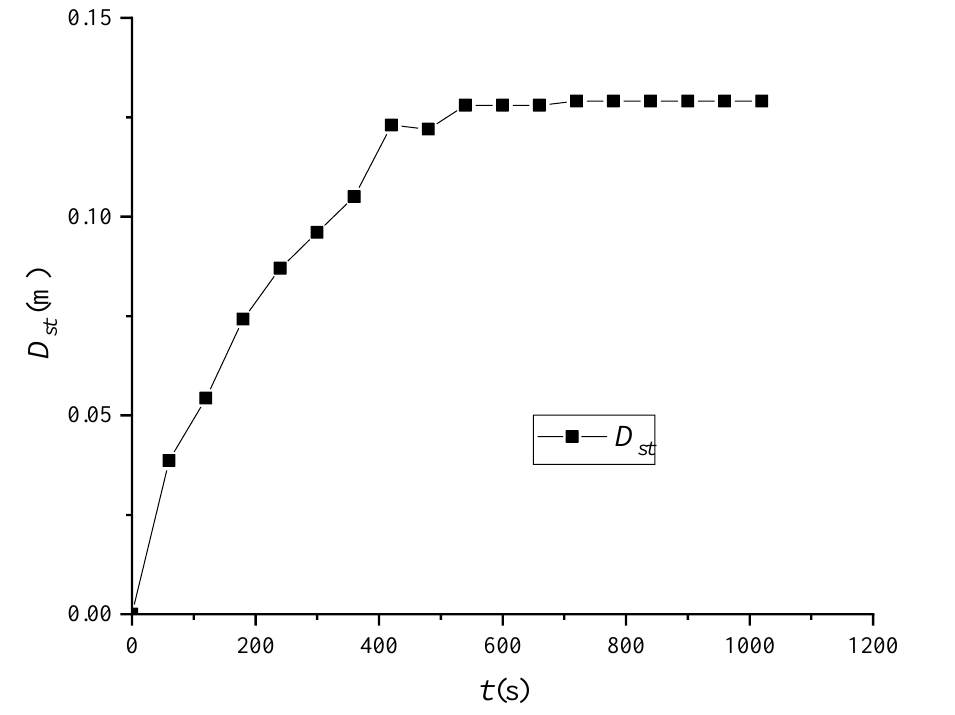
Figure 6. The temporal development of 𝐷 𝑠𝑡 in the numerical model. The comparison of final scour topography in the numerical model and experimental model are plotted in Figure 7. The upper part of Figure 7 is the topography of the experi- mental models, and the lower part is the topography of the numerical models. The central circle is the pile.